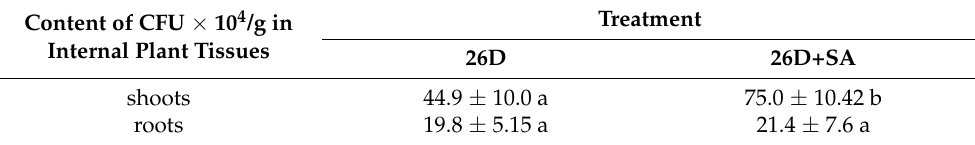
Table 2. Population of B. subtilis 26D in roots and shoots of potato plants (7 days after post- inoculation). Content of CFU × 10 4 /g in Internal Plant Tissues